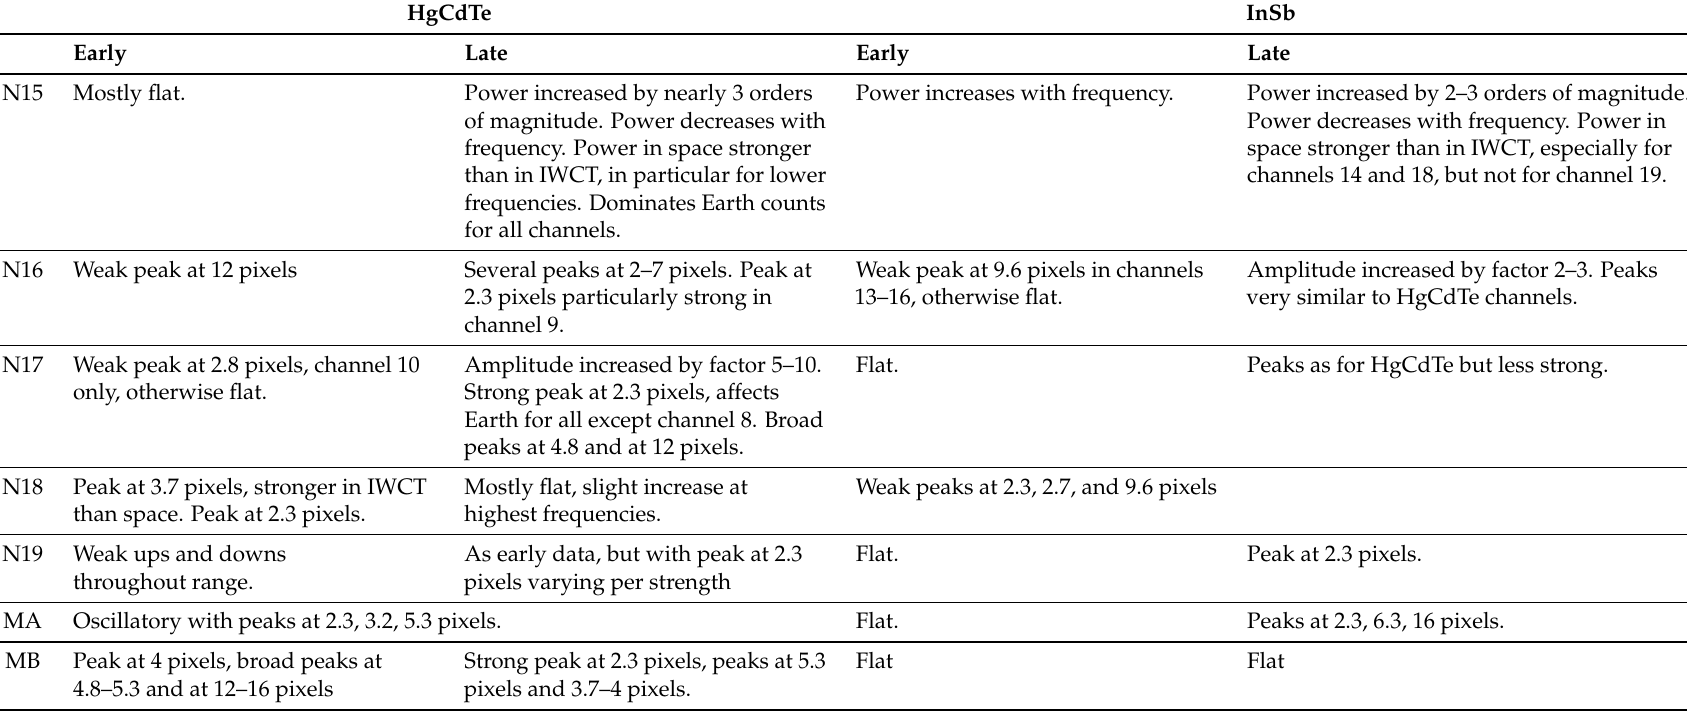
Table 4. As Table 3, but for HIRS/3 and